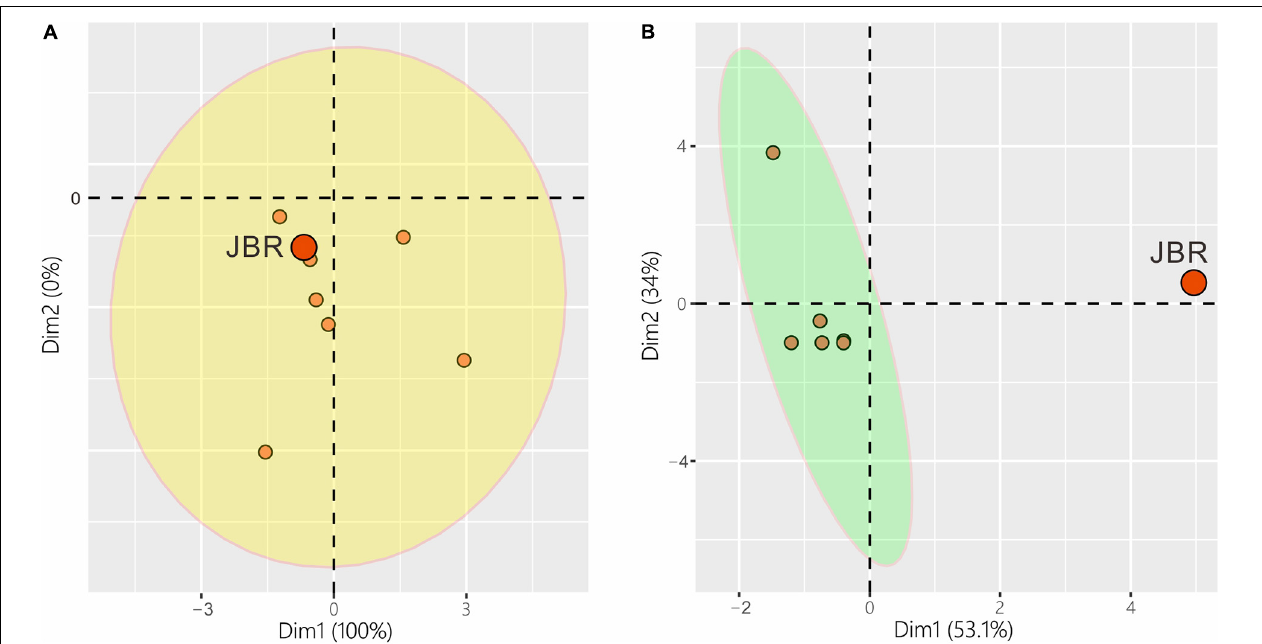
FIGURE 6 | PCA score of the first two principal components for the results of the charcoal analysis at JBR and archeological sites in the western Hexi Corridor oases. The red color represents results from JBR, and the orange color archeological sites in the oasis zone. (A) Comparisons of percentages of trees and shrubs between JBR and archeological sites in the oasis zone. (B) Comparisons of the percentages of different arboreal taxa between JBR and archeological sites in the oasis